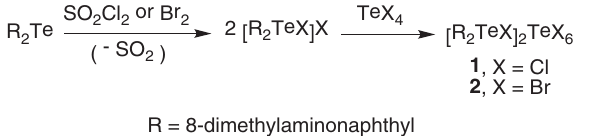
Figure 2 Molecular structure of [(8-Me showing 30% probability ellipsoids and the crystallographic num- bering